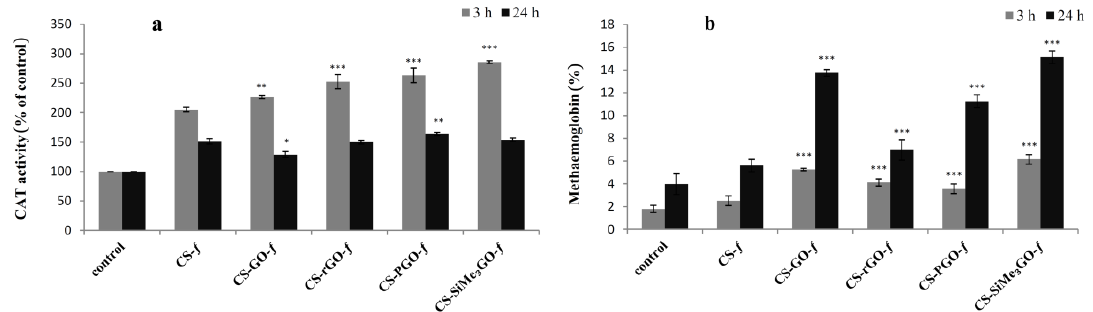
Figure 8. Catalase activity ( a ) and hemoglobin oxidation ( b ) of chitosan-reinforced graphene films.